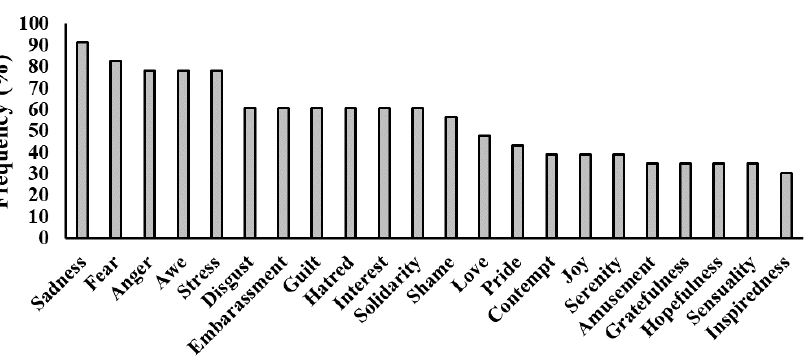
Figure 2. Proportion of Good Sleepers reporting each of the 22 emotions during the dream.